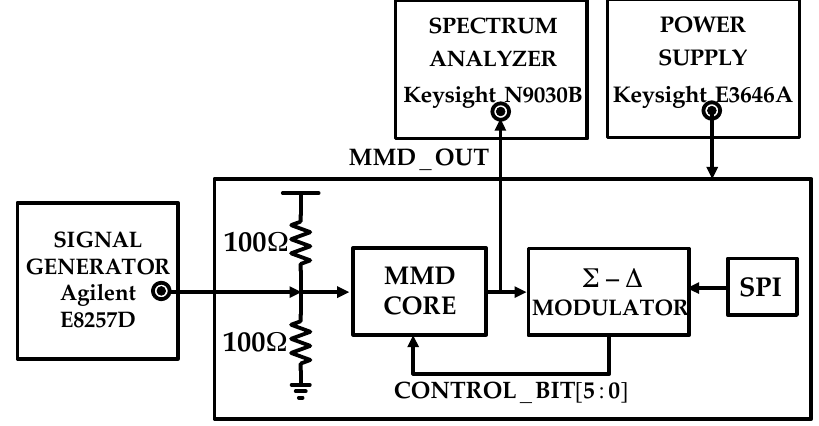
Figure 10. Test structure.